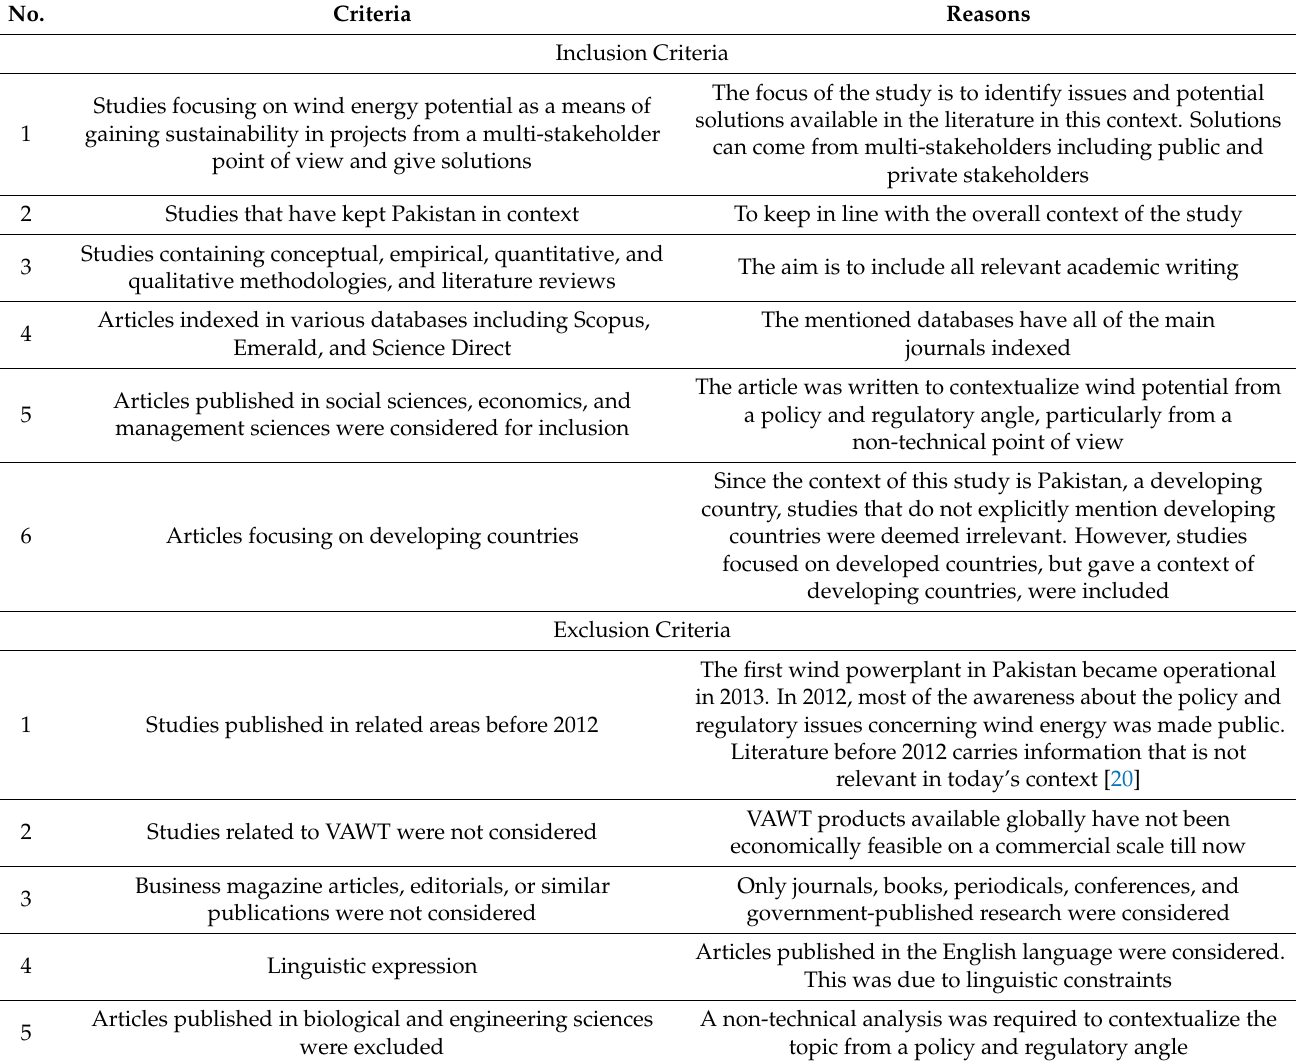
Table 1. Inclusion and exclusion